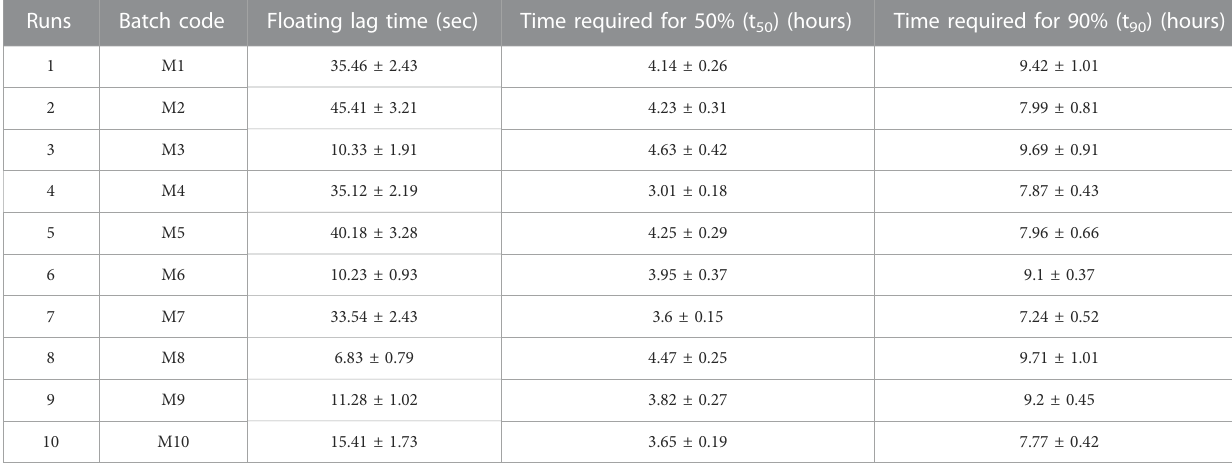
TABLE 4 Effect of independent factors on chosen responses.